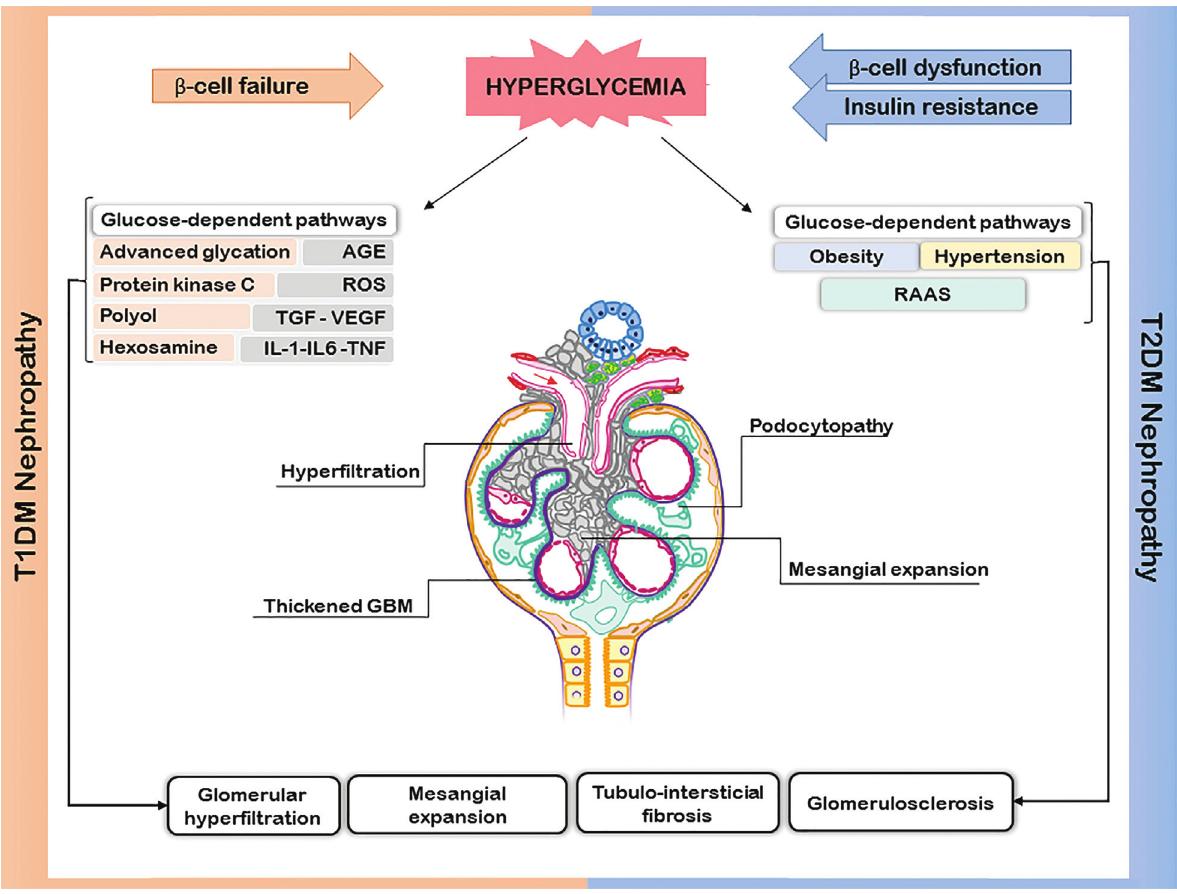
Figure 1 - DKD pathogenesis in T1DM and T2DM. Chronic hyperglycemia has a central role in the pathophysiology of DKD. In T1DM, chronic hyperglycemia activates several known pathways associated with the development and progression of the diabetic nephropathy, to cite: advanced glycation, polyol, hexosamine and protein kinase C pathways. In T2DM, besides these pathways, the presence of obesity and/or hypertension through hemodynamic mechanisms activates the renin-angiotensin-aldosterose system (RAAS), leading to glomerular hyperfiltration. All these factors partici- pateinthepathophysiologyoftheDKD,characterizedbythethicknessoftheglomerularbasementmembrane(GBM),podocytopathy,mesangialexpan- sion and glomerulosclerosis, and that are the key mechanisms to diabetic nephropathy. AGE: advanced glycation end-products; ROS: reactive oxygen species; TGF: transforming growth factor; VEGF: vascular endothelial growth factor; IL: interleukin; TNF: tumor necrosis